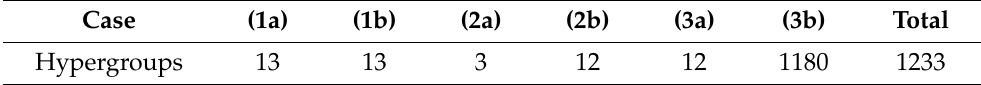
Table 1. Number of non-isomorphic, non-complete 1-hypergroups found in case 3, | H | =